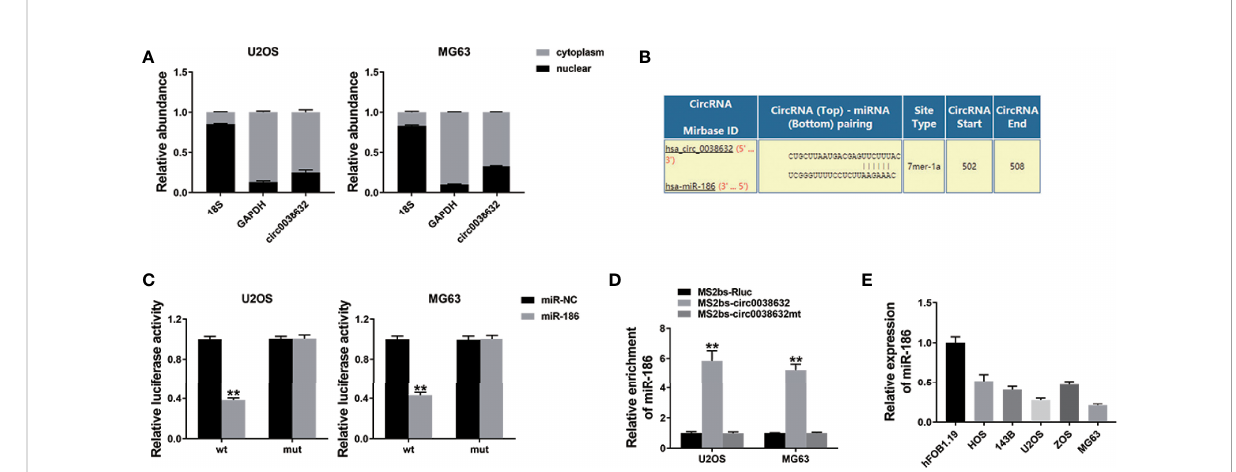
FIGURE 3 circ0038632 serves as miR-186 sponge in osteosarcoma. (A) qRT-PCR detected circ0038632, cytoplasmic control (GAPDH), and nuclear control (18S) expression. (B) Potential binding sites between miR-186 and circ0038632. (C) Relative luciferase activities of different co- transfected groups. (D) The enrichment of MS2bs-circ0038632, MS2bs-circ0038632mt, or control group was assessed. (E) The expression of miR-186 in osteosarcoma cell lines. ** P <